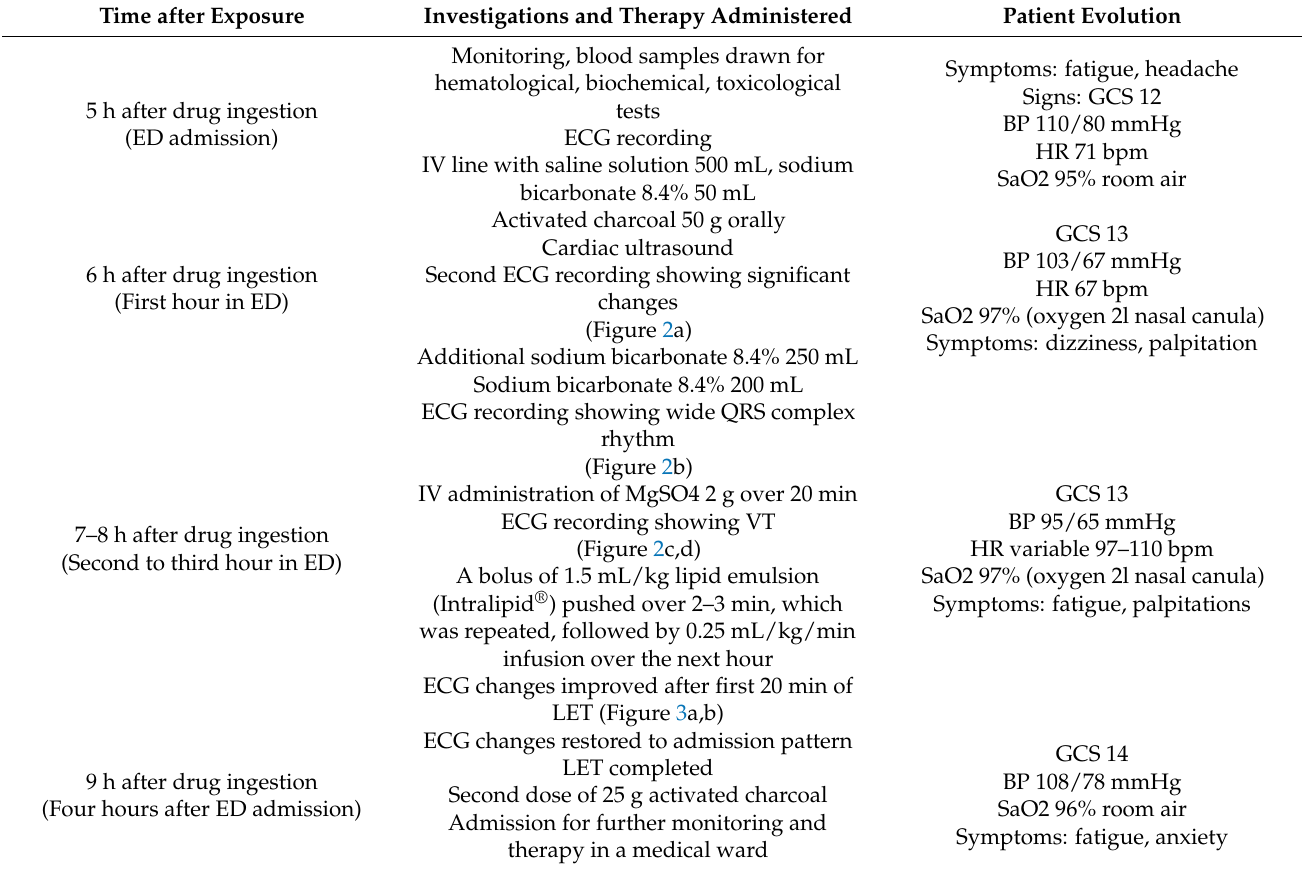
Table 1. Patient’s evolution during ED admission and therapy